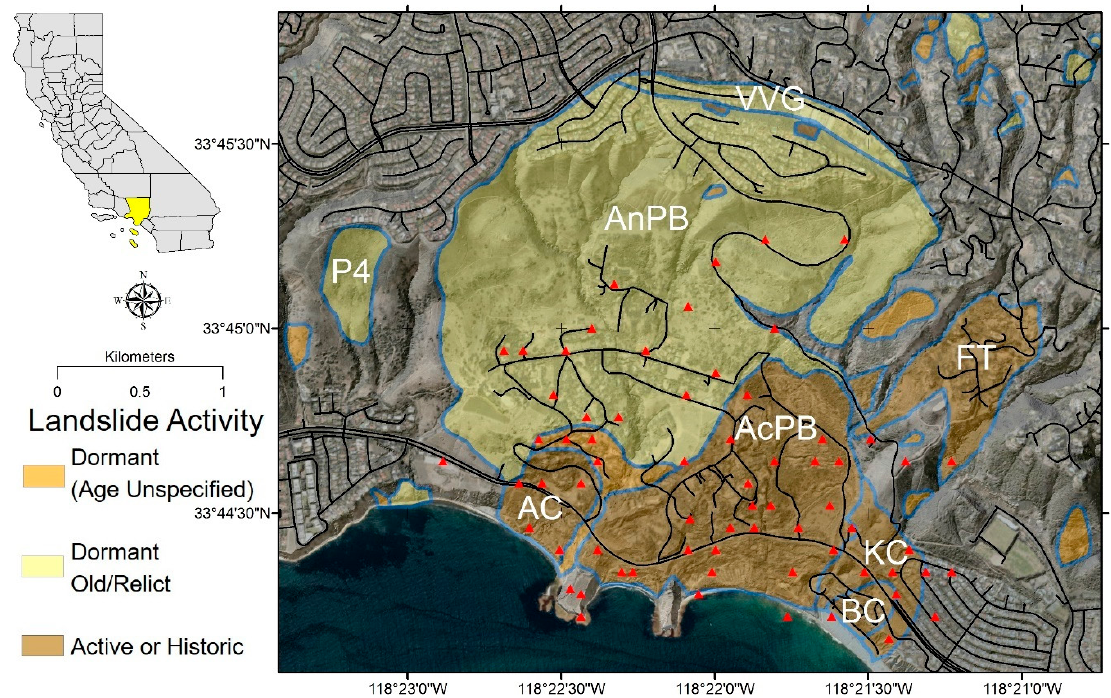
Figure 1. Study area. Inset shows location of Los Angeles County (highlighted in yellow) within the state of California. Major landslides, colored based on landslide activity [24], are Ancient Portuguese Bend (AnPB), Active Portuguese Bend (AcPB), Valley View Graben (VVG), Parcel 4 (P4), Abalone Cove (AC), Klondike Canyon (KC), Beach Club (BC), and Flying Triangle (FT). Boundaries between each landslide are shown in blue. GPS monuments are displayed as red triangles. Roads are shown as black lines. Background hillshade produced by [72]. Table 2. Landslide characteristics.